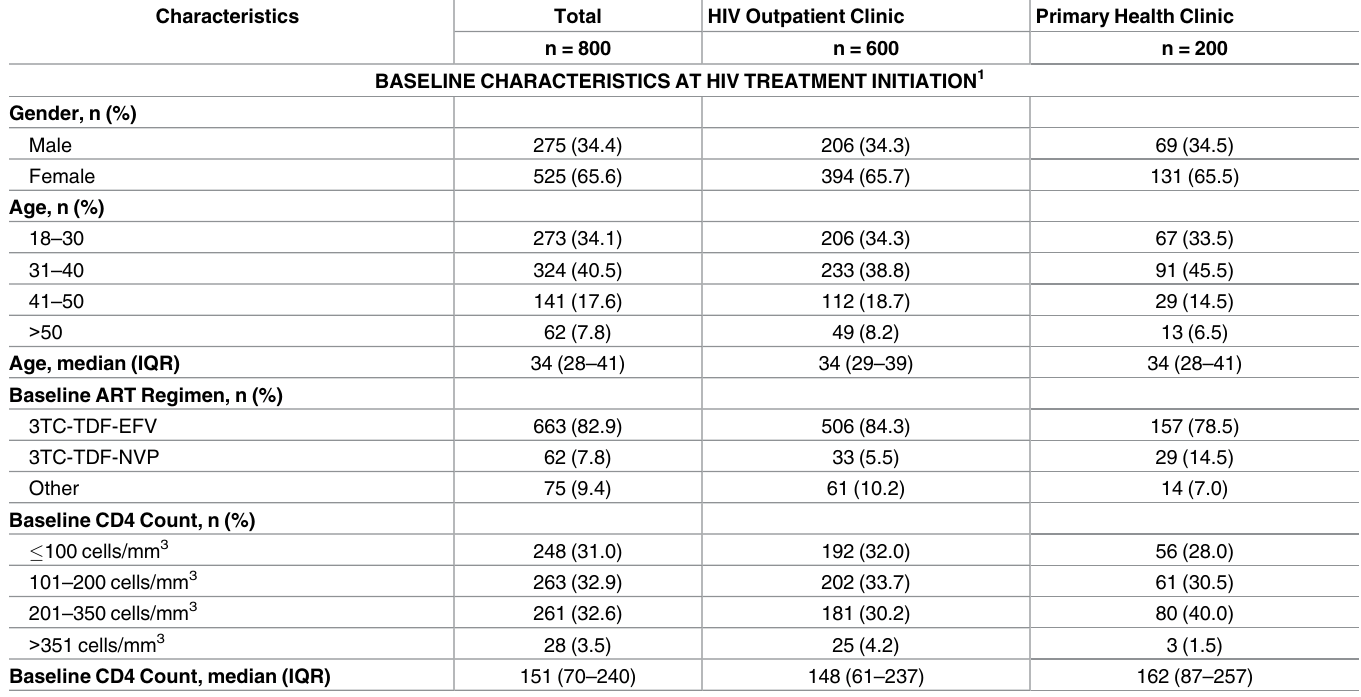
Table 2. Baseline characteristics at HIV treatment